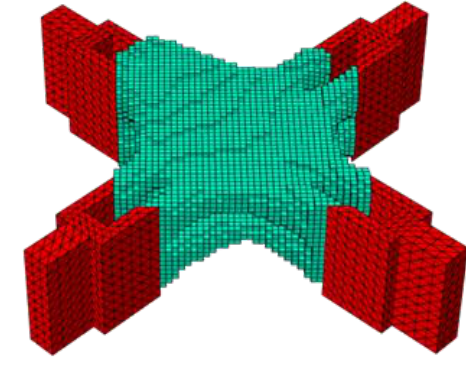
Figure 6. Optimized molding effect after improvement with different angles, showing a smoother profile (the red part is the load application area, and the green part is the design domain).